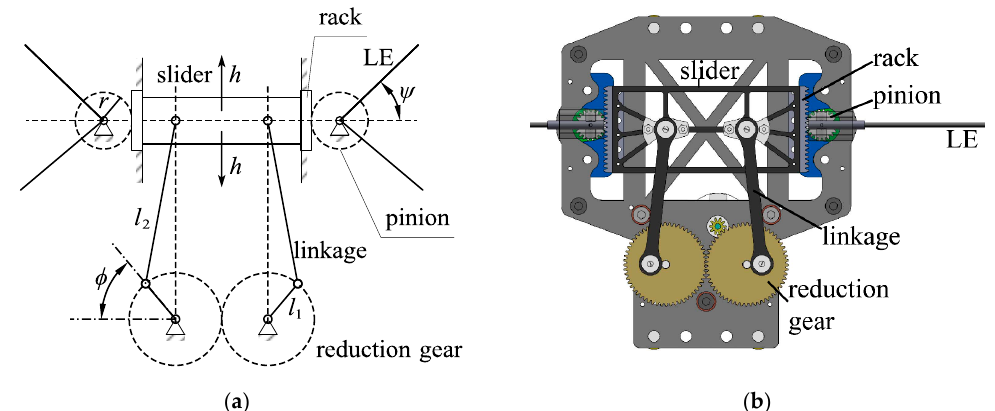
Figure 1. ( a ) Schematic of the flapping wing mechanism; ( b ) Assembled CAD model of the flapping wing mechanism.